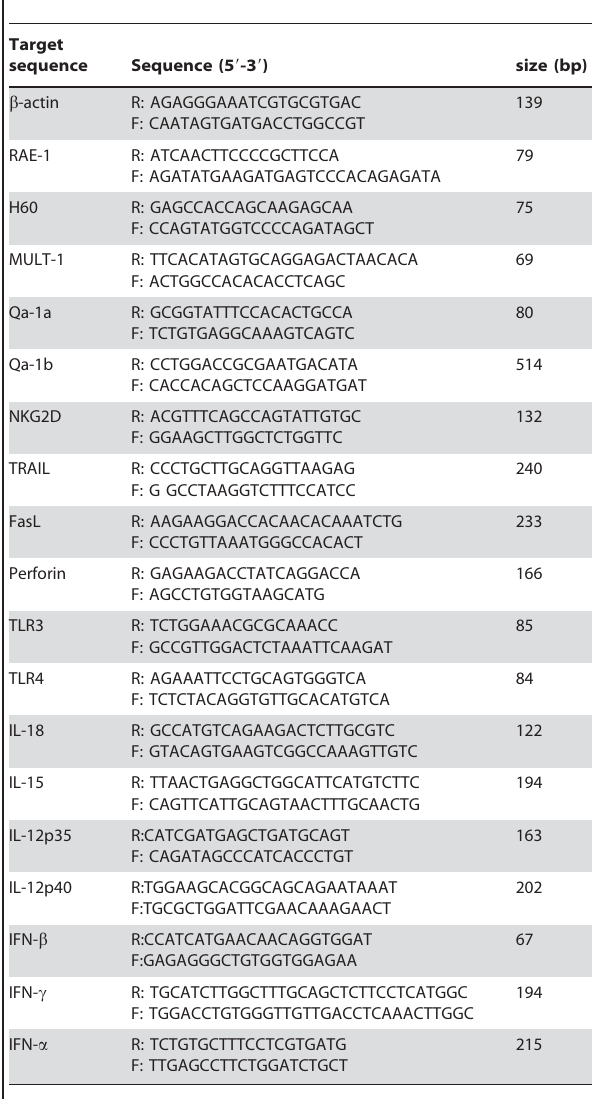
Table 1. Sequences of primer used for real-time PCR assay.